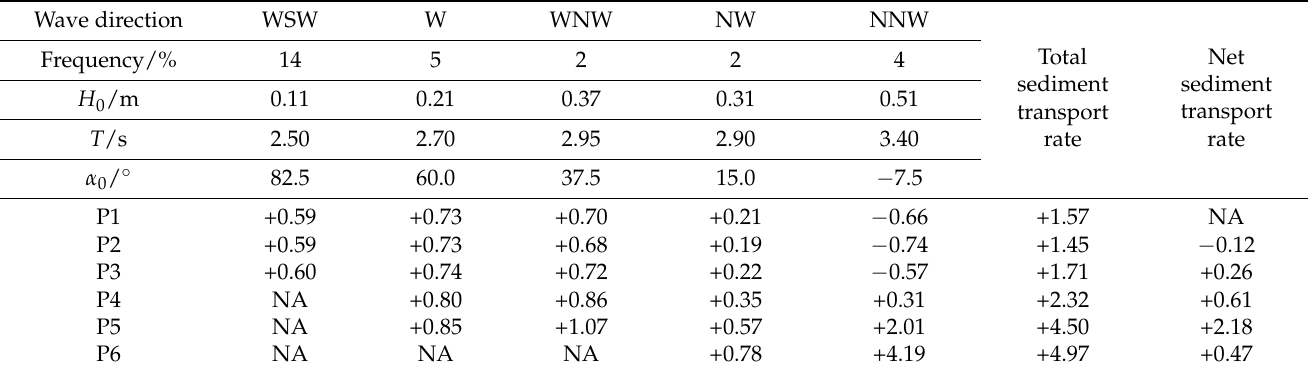
Table 3. Coastal sediment transport rate of sections in FESL (unit: 10 4 m 3